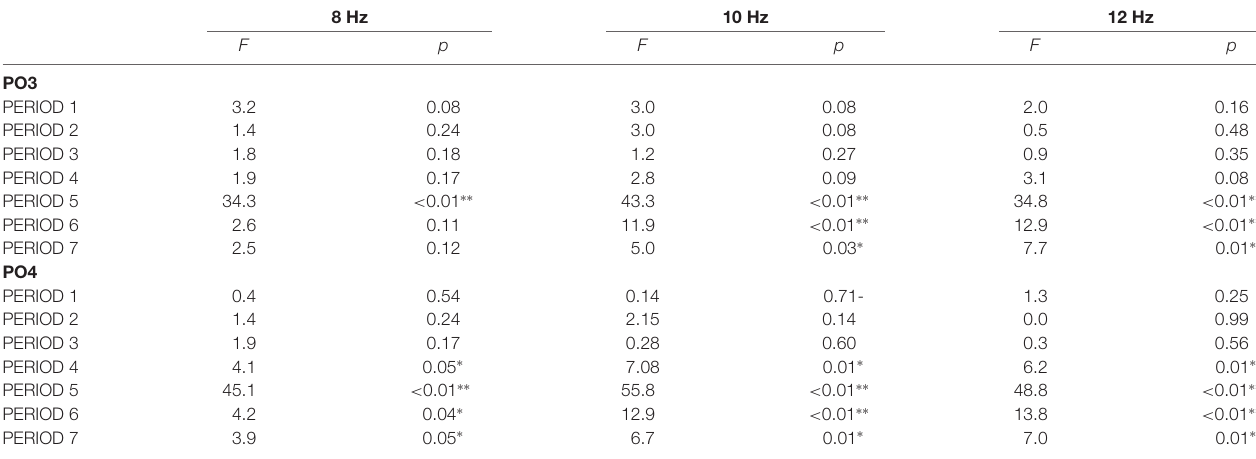
TABLE 2 | The difference in the event-related power change between the working memory task and the self-reflection task in regions of interest